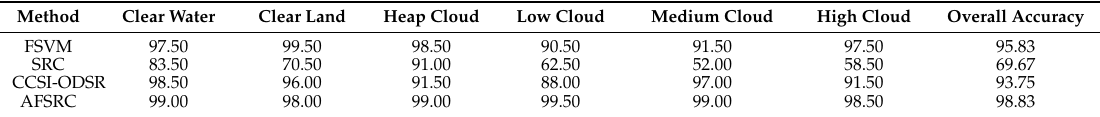
Table 5. Classification accuracy (%) of different cloud types by four methods.